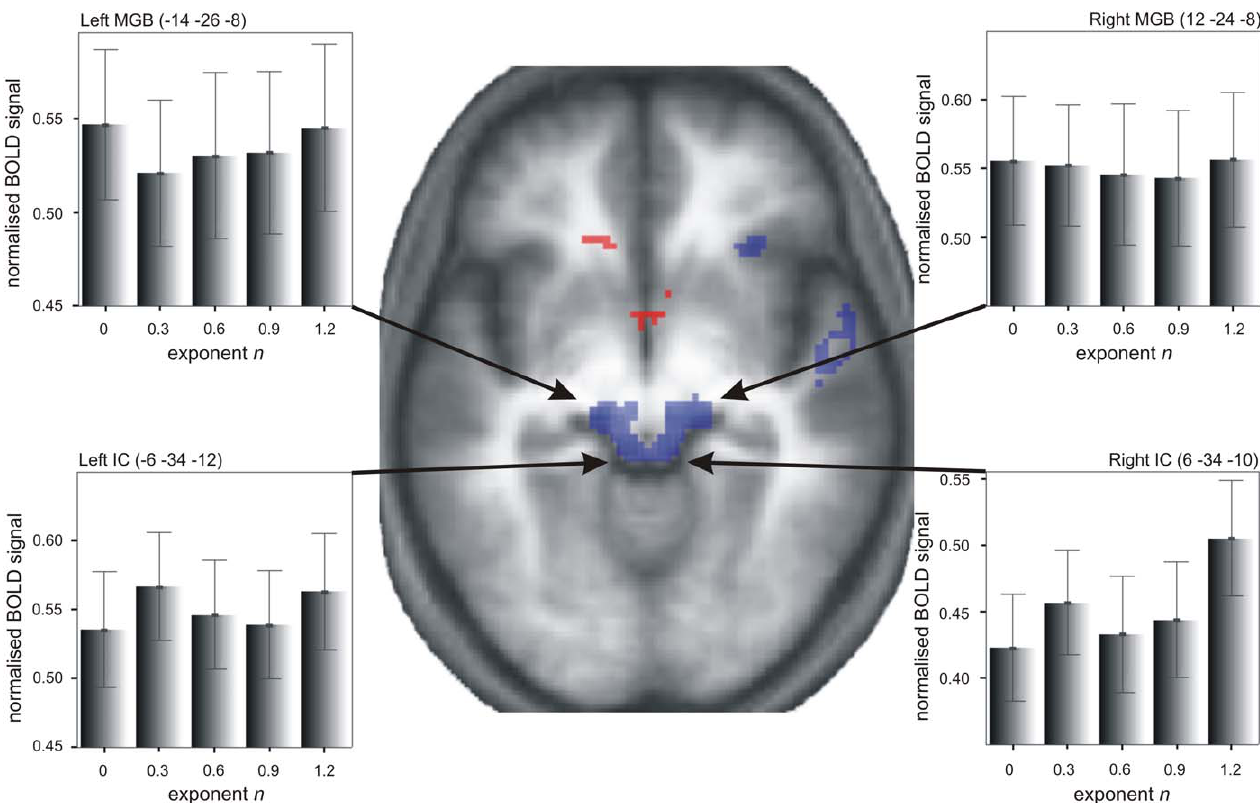
Figure 5. Study 2 Functional Imaging Data: Response in Subcortical Structures Entropy increase ( p , 0.001, uncorrected) (red) and [sound–silence] ( p , 0.05, FWE corrected) (blue) contrasts superimposed on a horizontal section ( z ¼ (cid:2) 10) of participants’ normalised average structural scan that covers IC and MGB (note that z coordinates vary slightly between maxima and arrows, therefore they are only indicative of the exact location). Normalised mean percent BOLD signal change ( 6 SEM) at the local maxima in left and right IC (bottom) and MGB (top) is plotted for the five levels of exponent n